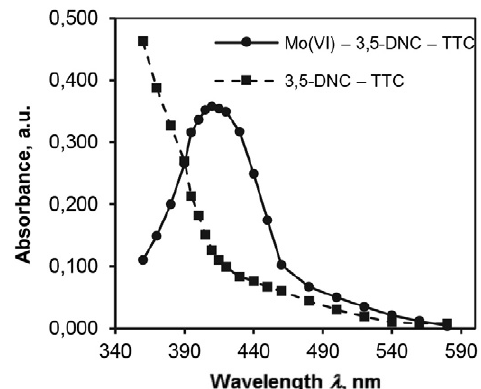
Figure 1. Absorption spectra of the complex Mo(VI)‒3,5-DNC‒ TTC and of the blank sample 3,5-DNC‒TTC in CHCl 3 C Mo(VI) = 1.6 × 10 ‒5 mol L –1 ; C 3,5-DNC = 1.2 × 10 ‒3 mol L –1 , C TTC = 2.4 × 10 ‒4 mol L –1 ; C H2SO4 = 4.5 × 10 –1 mol L –1 ; λ = 410 nm; τ = 3 min Table 1. Optimum extraction-spectrophotometric conditions and analytical characteristics of the system